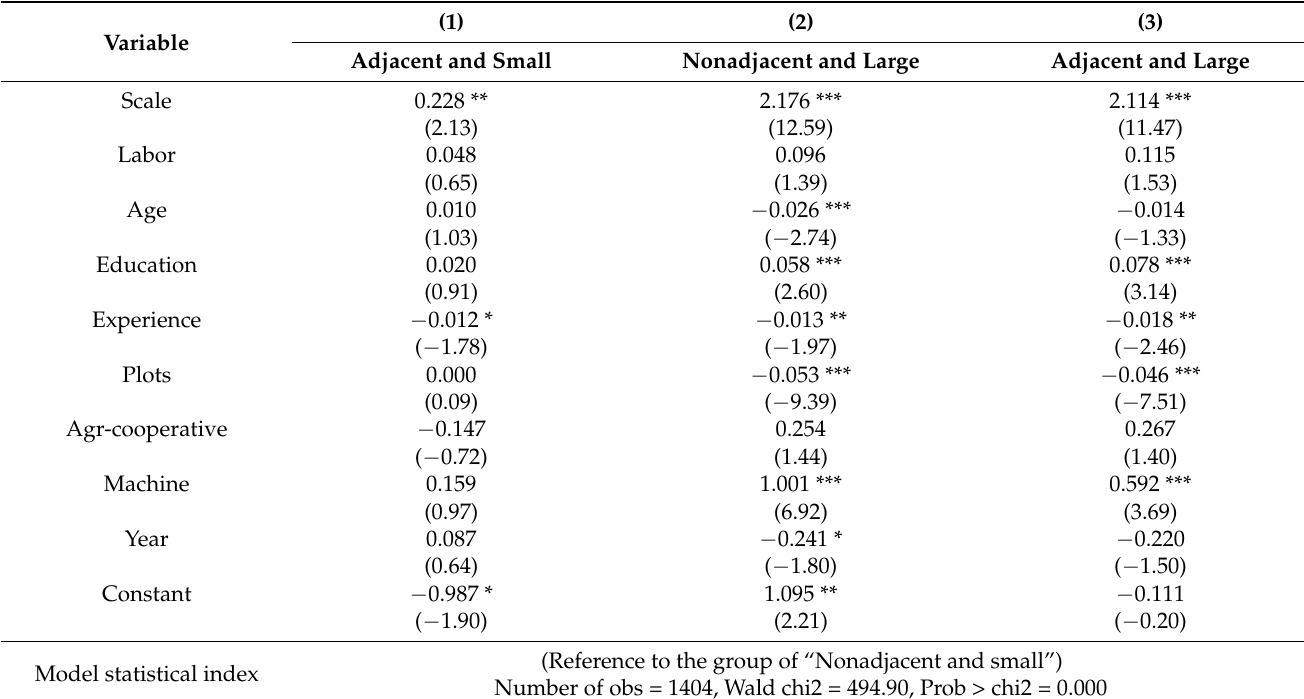
Table 5. The results of the multivariate probit model test on the spatial heterogeneity of different household transfer